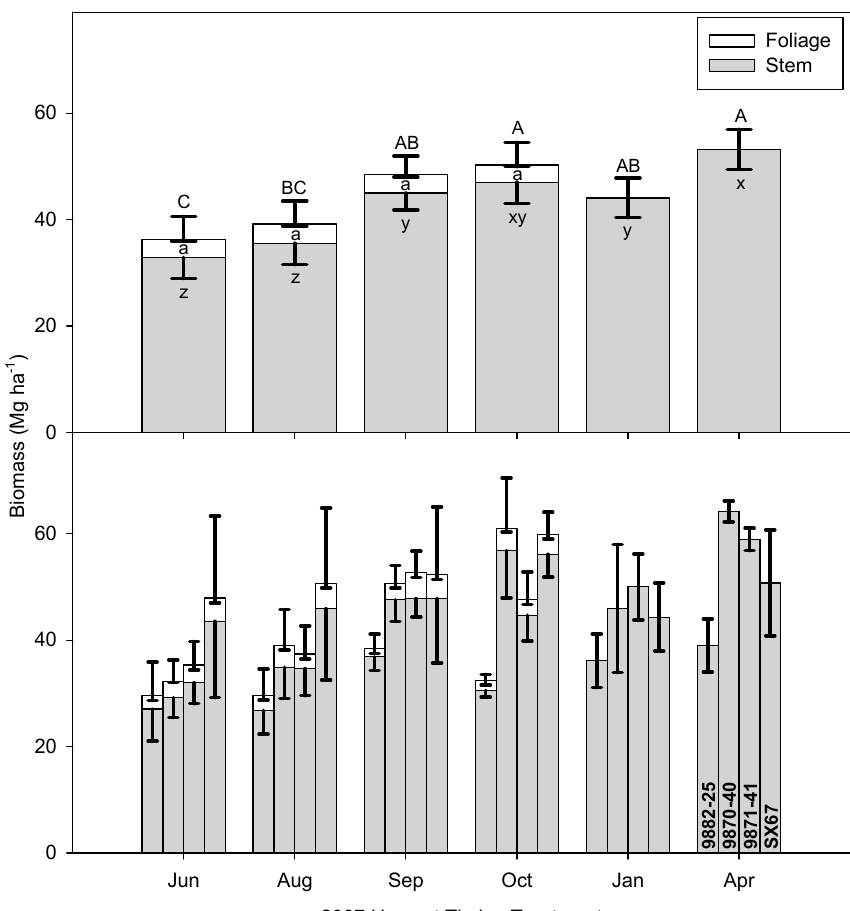
Figure 2. ( Top ) Mean willow stem and foliage biomass production for the first rotation time-of- harvest treatments (ToH) that occurred on the prescribed ToH areas between June 2007 and April 2008. Letters indicate significant differences between total biomass (upper case A-B-C), foliar biomass (lower case a-b-c), and stem biomass (lower case x-y-z). One-way error bar indicates the standard error for the arithmetic mean for total biomass (upward), downward in the white space for foliage, and downward in the gray space for stem components. ( Bottom ) Sets of bars showing stem and foliage biomass for individual cultivars as labeled on the rightmost group.